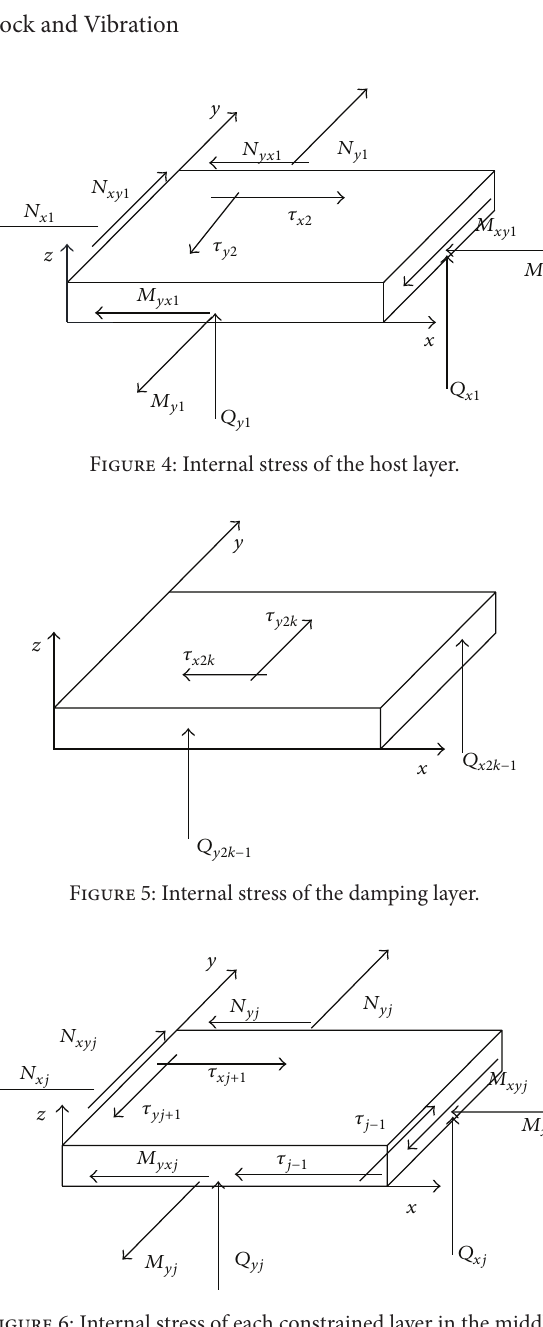
Figure 6: Internal stress of each constrained layer in the middle.